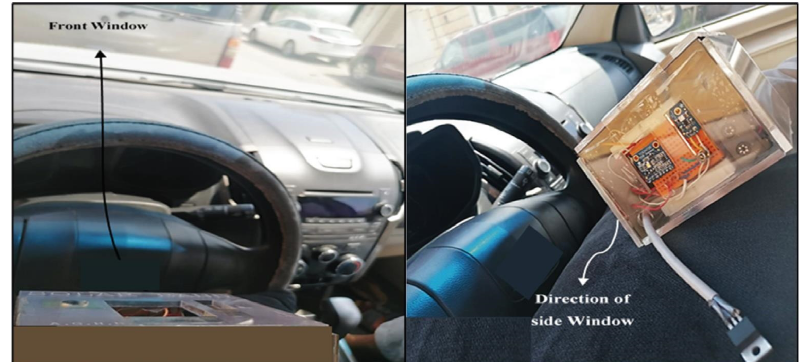
Figure 14: Orientation of prototype inside the vehicle, the top view oriented to the front window, while the left side view oriented to the side window.